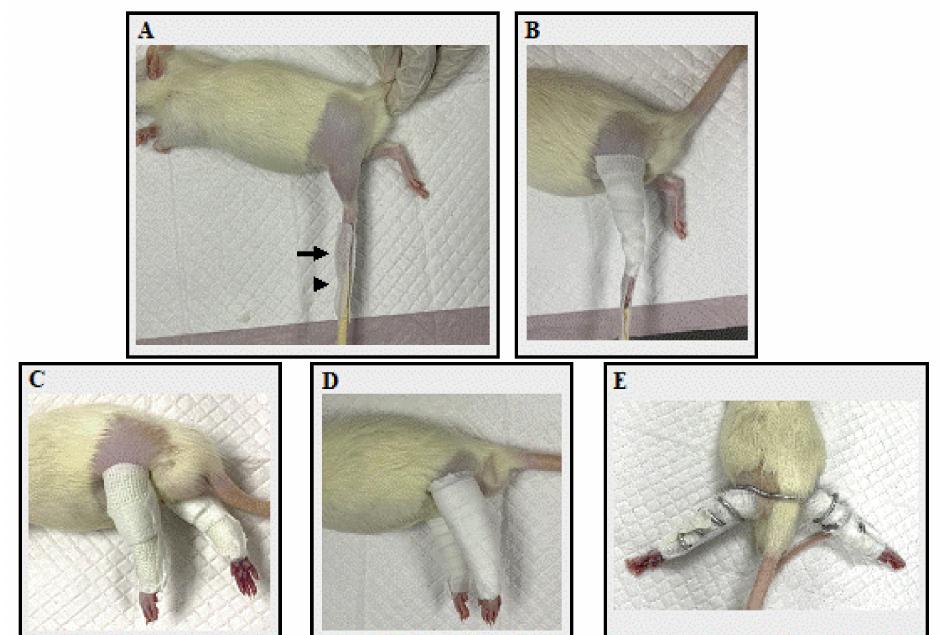
Figure 1. The fixation application processes. ( A ) The application of adhesive tape. The black arrow indicates the rat’s toe, which was attached with adhesive tape, while the black arrowhead indicates a chopstick splint, also attached with adhesive tape. ( B ) Non-elastic bandage tape was applied. ( C ) A rats’ hindlimb in Group I after a cast bandage was applied. ( D ) A rats’ hindlimb in Group V after a Velcro bandage was applied. ( E ) A rats’ hindlimb in Group S after spiral wire was